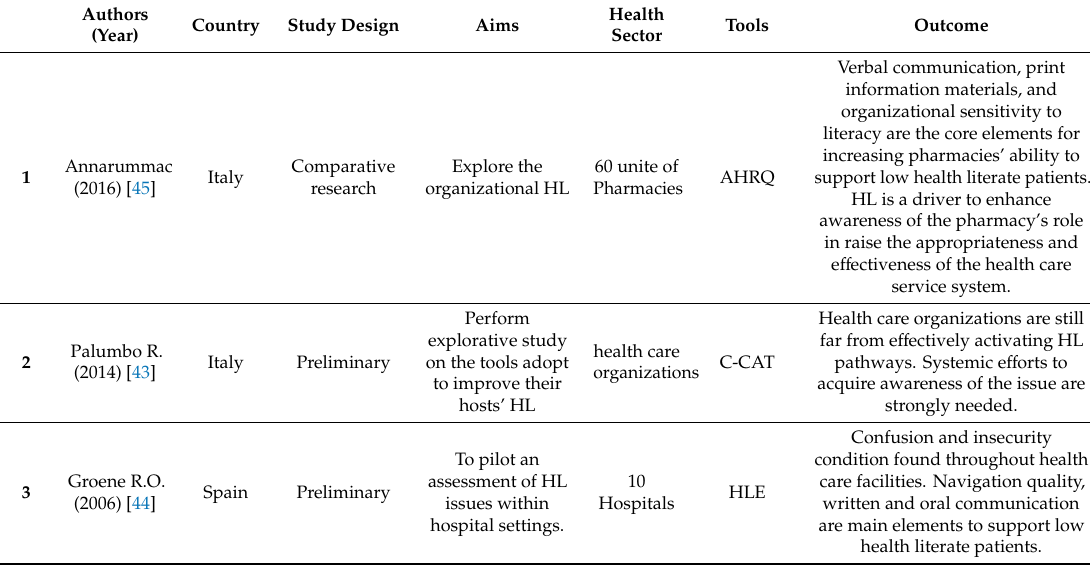
Table 2. Characteristic Included